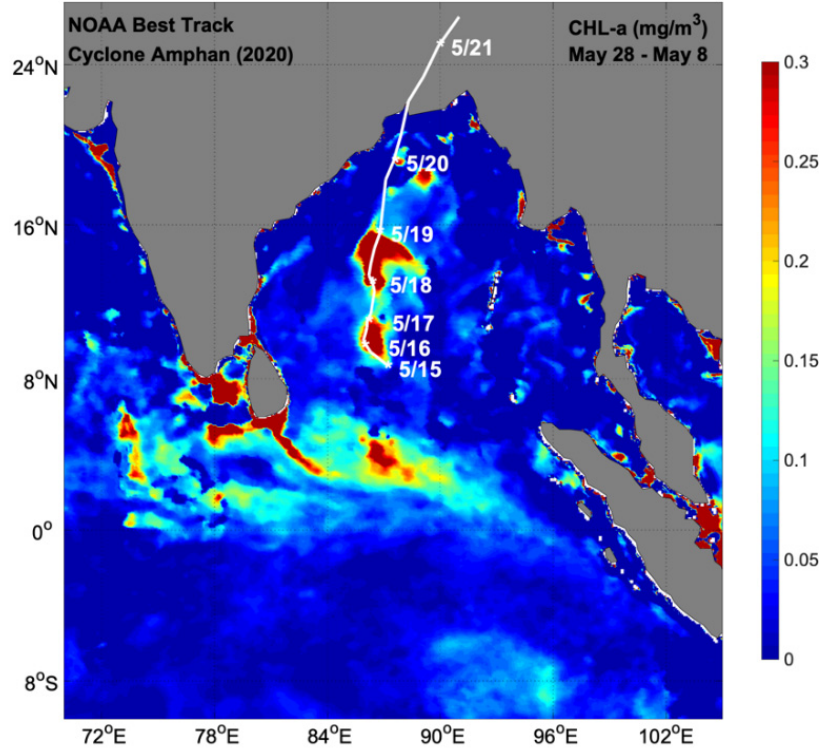
Figure 1. National Oceanic and Atmospheric Administration (NOAA) Coastwatch gap-filled ocean color chlorophyll-a (CHL-a; shaded; mg / m 3 ) for the di ff erence between May 28, 2020 and May 8, 2020 in the Bay of Bengal overlaid with NOAA Satellite Services Division (SSD) best track data from the Joint Typhoon Warning Center (JTWC) for Cyclone Amphan